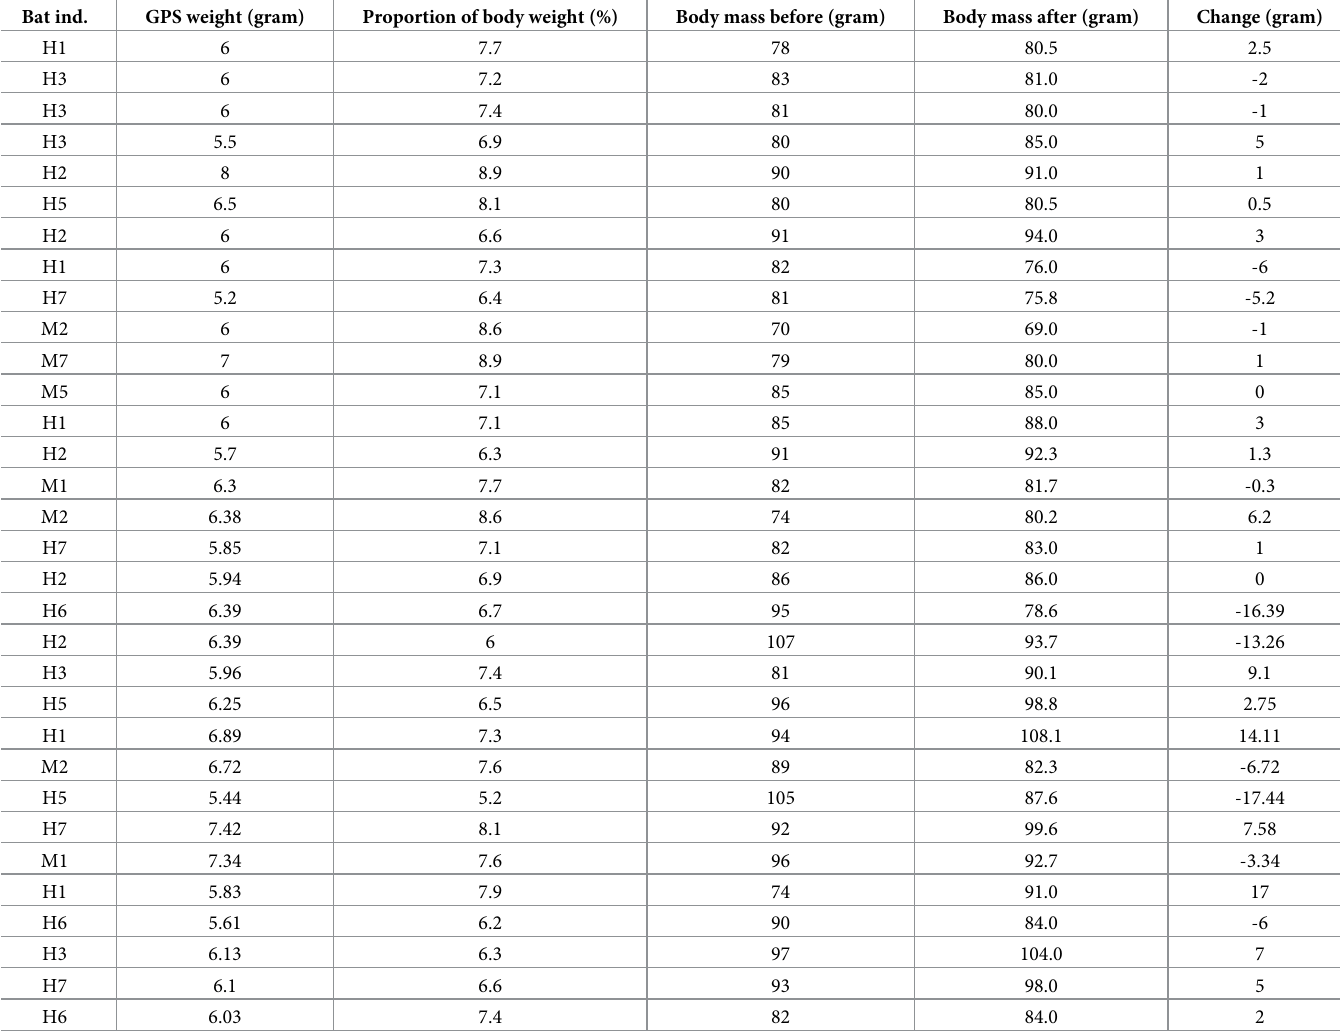
Table 2. Mass before and after GPS placements. Bat ind.